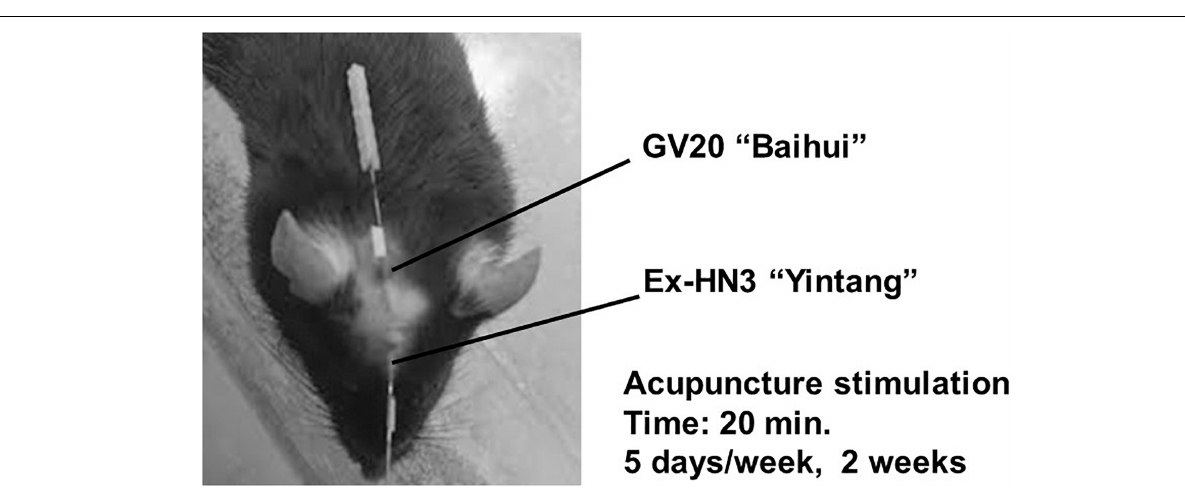
FIGURE 3 | Acupuncture points. Horizontal and inward simultaneous acupuncture stimuli were continued for 20 min with insertion to a depth of 5 mm at the “Bai-Hui” (GV20) and “Yintáng” (Ex-HN3) acupuncture points using stainless steel needles (diameter, 0.25